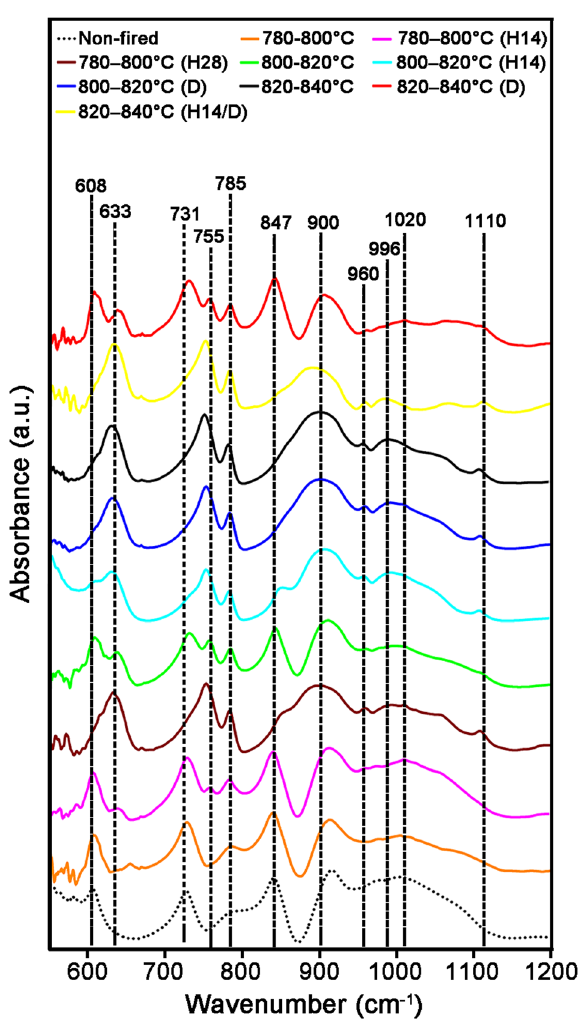
Fig. 4 FTIR spectra of LDGC materials heated under various thermal conditions